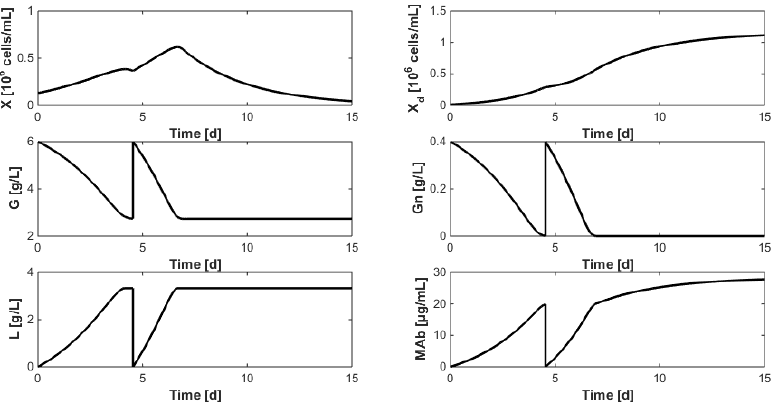
Figure 10. Optimization of the renewal time with medium substrate concentrations respectively set to G = 6 g/L and Gn = 0.4 g/L ( α = 0), while maximizing monoclonal antibody production.